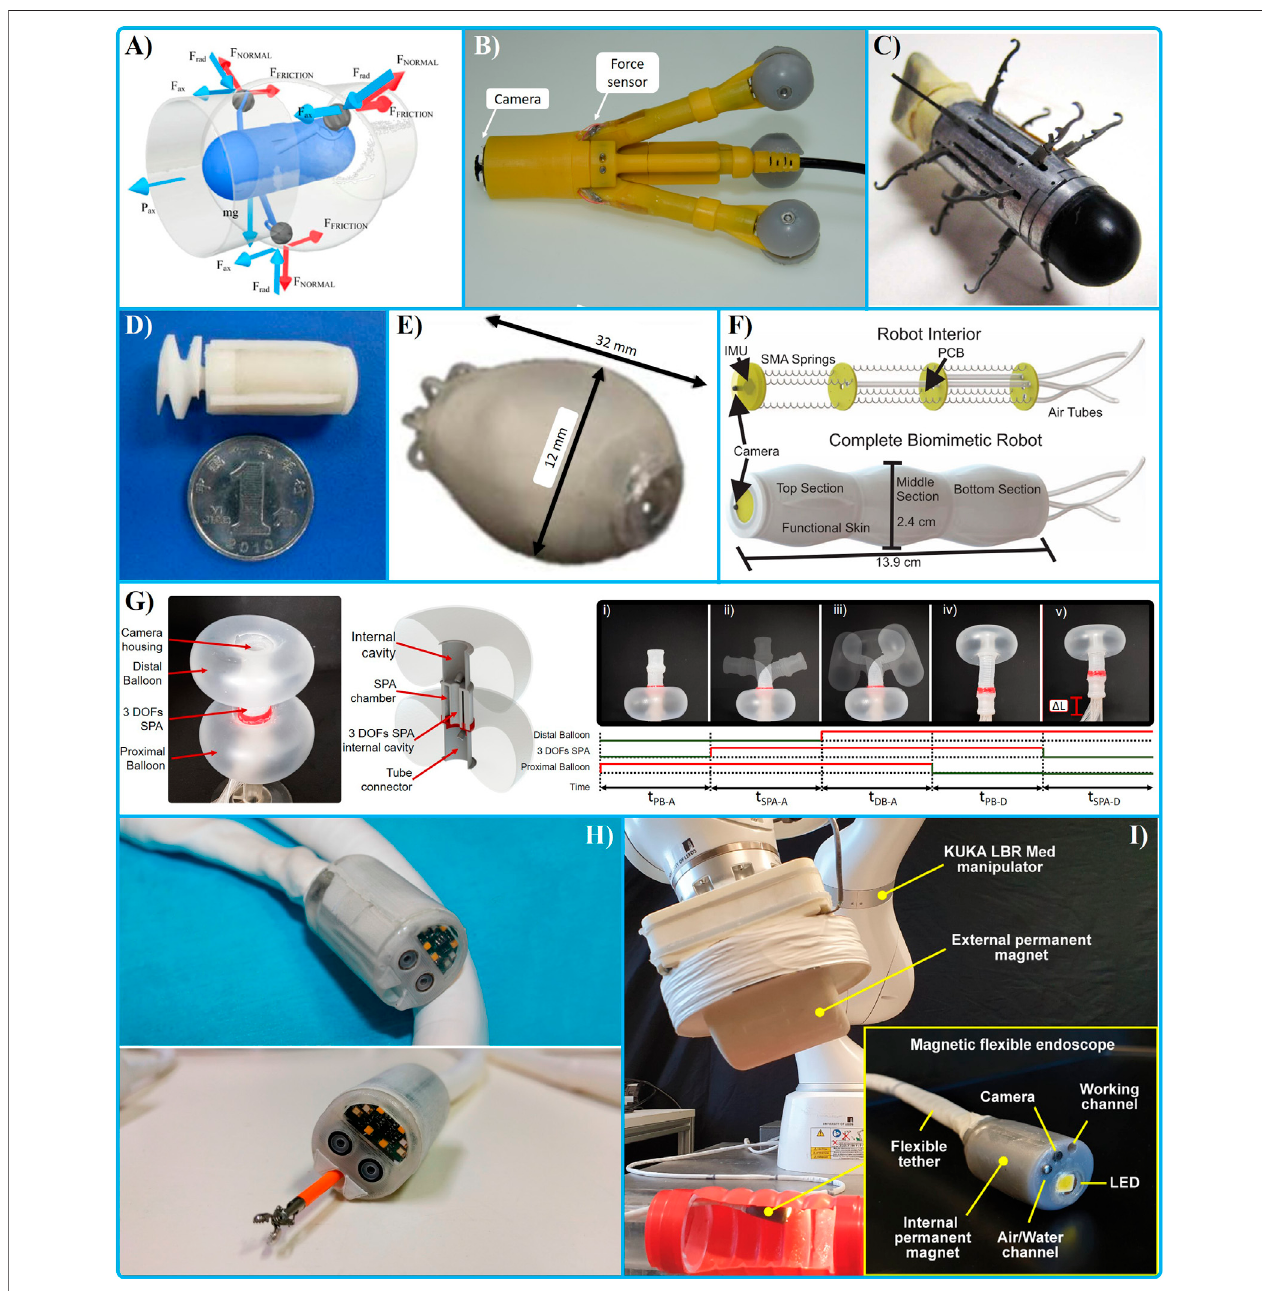
FIGURE 1 | Internal actuators: with wheels (A, B) (Karargyris and Koulaouzidis 2015; Norton et al., 2016), (C) legs (Valdastri and Webster, 2009), propellers (D, E) (Liang et al., 2011; Falco et al., 2014), small inchworm locomotion capsule (F) (Alcaide, Pearson, and Rentschler 2017), (G) a Soft Pneumatic Inchworm Double-balloon (SPID) (Manfredi et al., 2019); Wireless locomotion: Endoo Project (H) (Ciuti et al., 2020) autonomous navigation (I) (Martin et al., 2020).